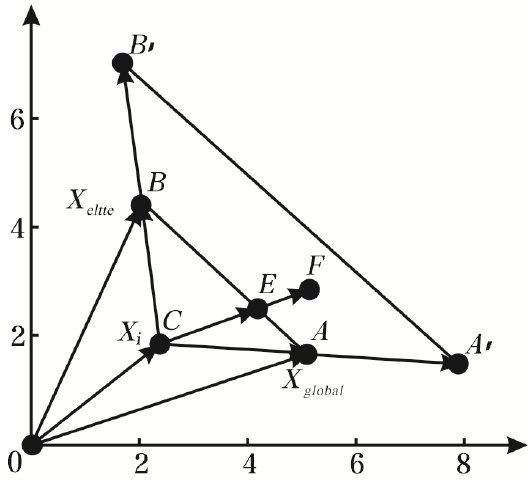
Figure 3. Aggregate Operation.